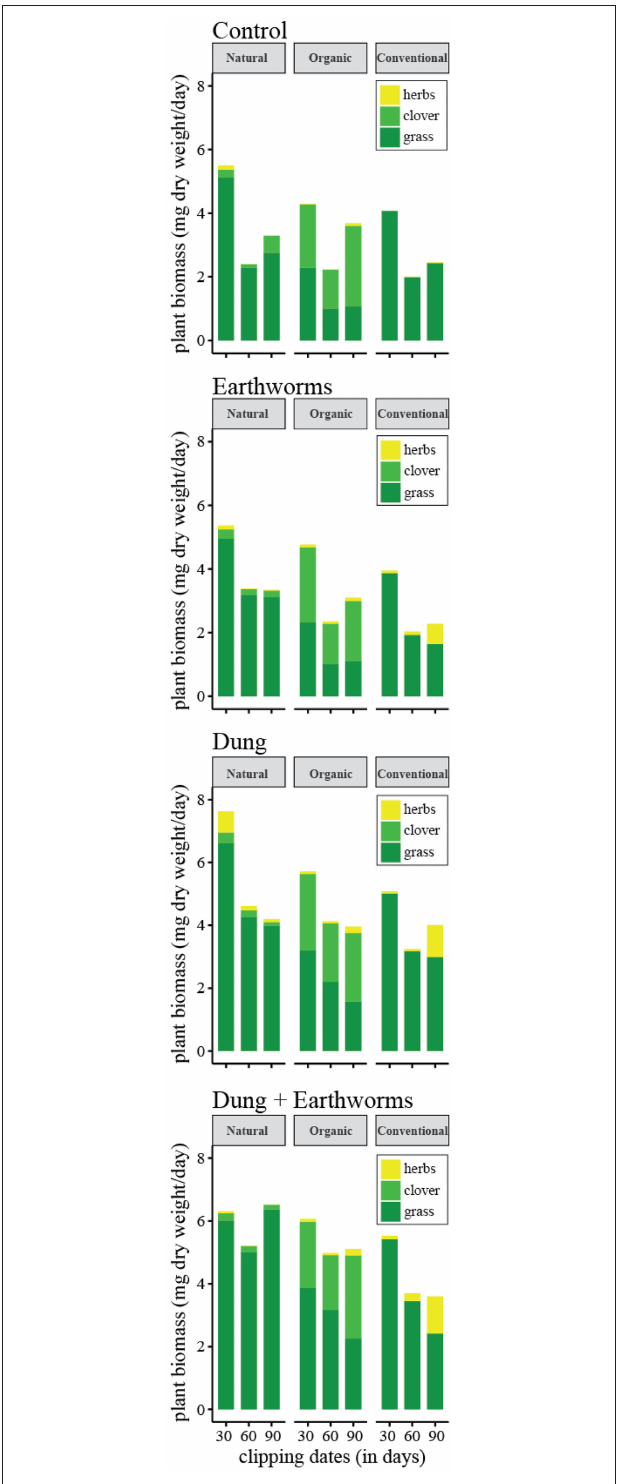
FIGURE 1 | Plant productivity in the soil cores throughout the experiment expressed in mg of plant dry weight produced per day. Plants were clipped three times every 30 days and categorized as grass, clover, and herbs before drying. Each bar represents the mean plant productivity for soil cores of the same soil management and treatment.